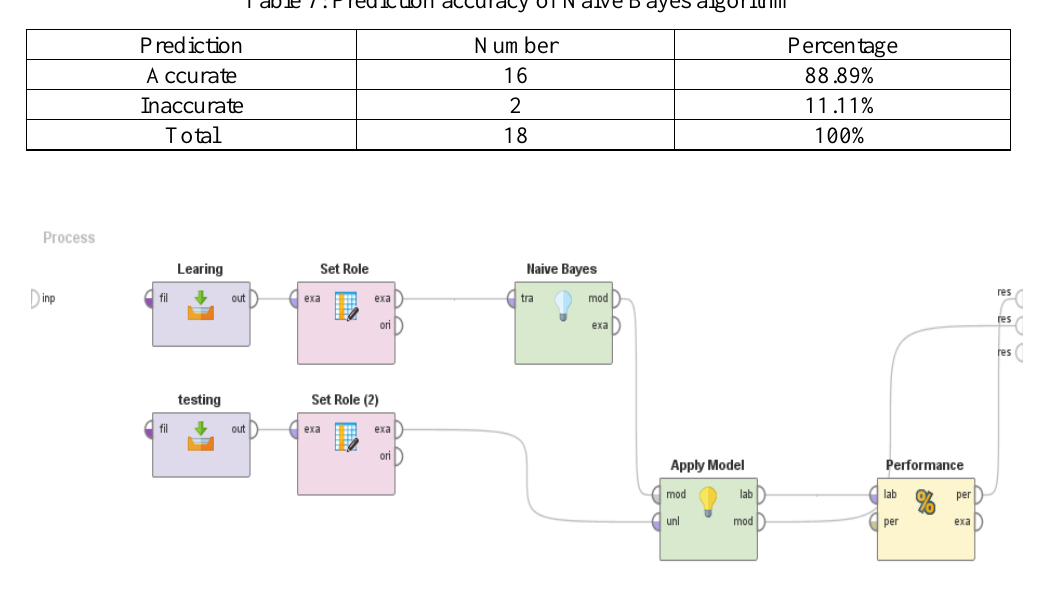
Table 7: Prediction accuracy of Naive Bayes algorithm